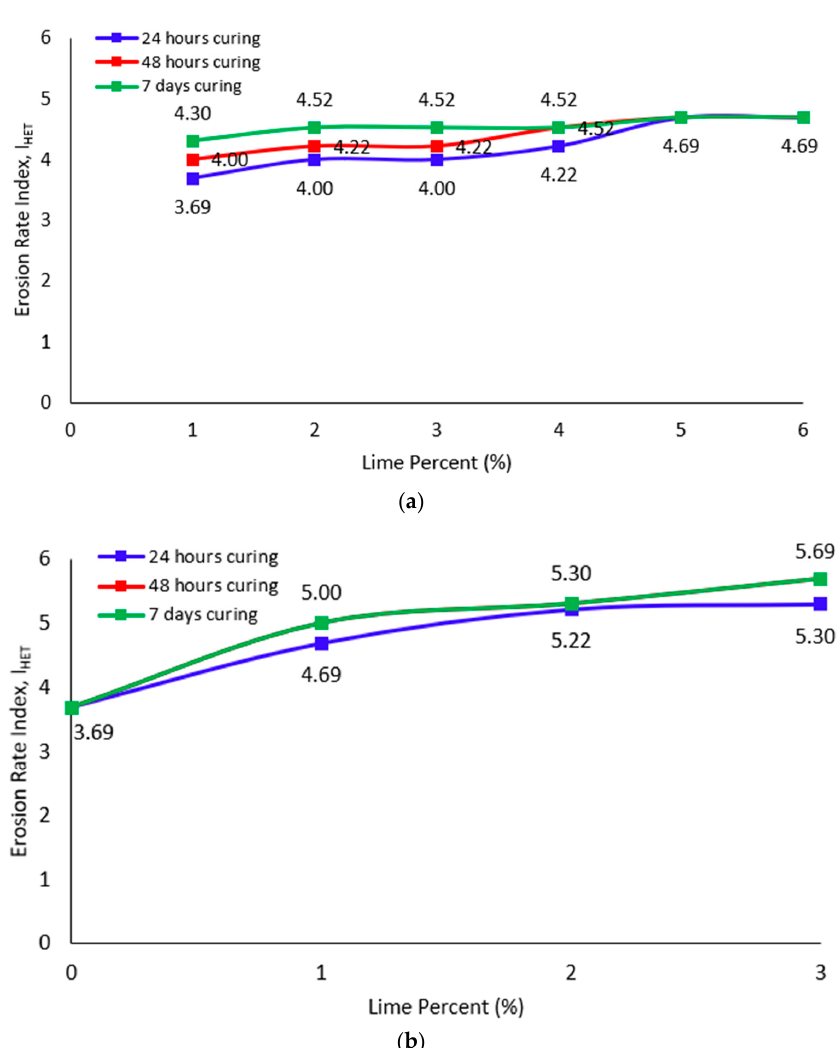
Figure 6. Erosion rate index (I HET ) versus lime percent (%) for ( a ) Soil #1 and ( b ) Soil #2 with various curing times.